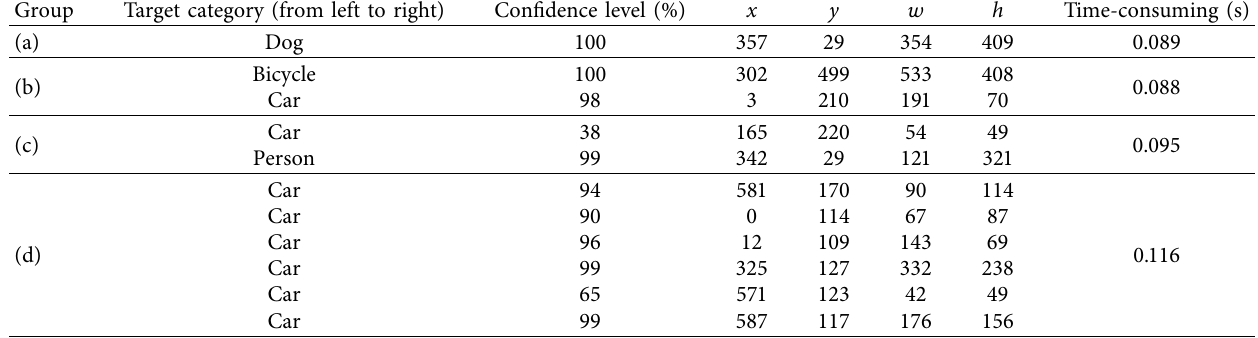
Table 5: Analysis of obstacle recognition performance of YOLO convolutional neural network. Group Target category (from left to right)